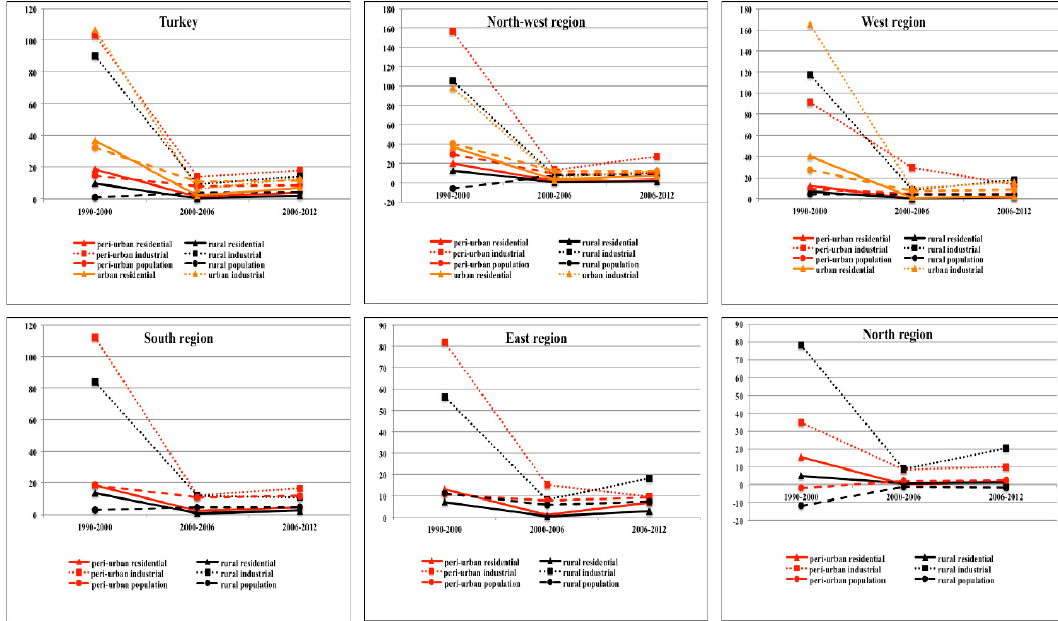
Figure 8. Residential, industrial and population growth (%) at national and regional level for urban, peri-urban and rural regions from the upper left corner: Turkey, North-west region, West region, South peri ‐ urban and rural regions from the upper left corner: Turkey, North ‐ west region, West region, region, East region, North South region, East region, North region.